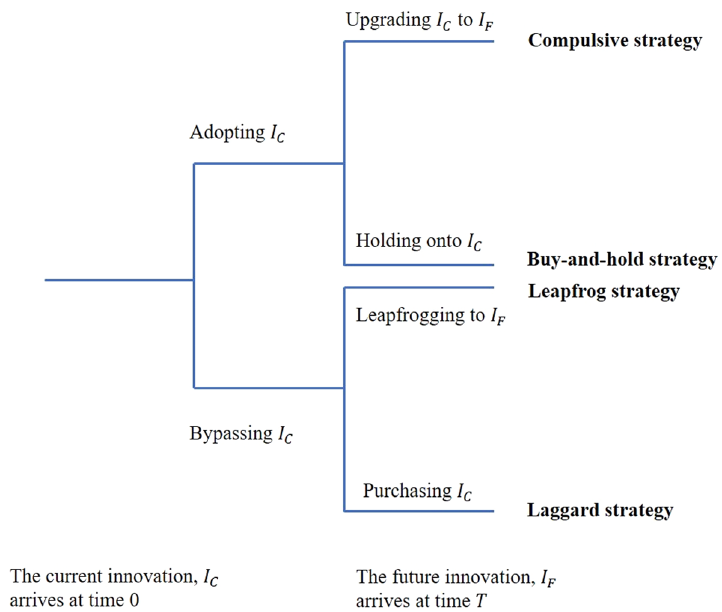
Fig. 1 Managers’ strategies for adopting current and future innovations. When the current innovation, I C arrives, managers can either adopt or bypass it. Managers’ strategies for adopting future innovation, I F depend on the strategy for I C . After the early adoption of I C , managers can either upgrade to I F or hold on to it. If managers bypass I C , they can either leapfrog to I F or purchase I